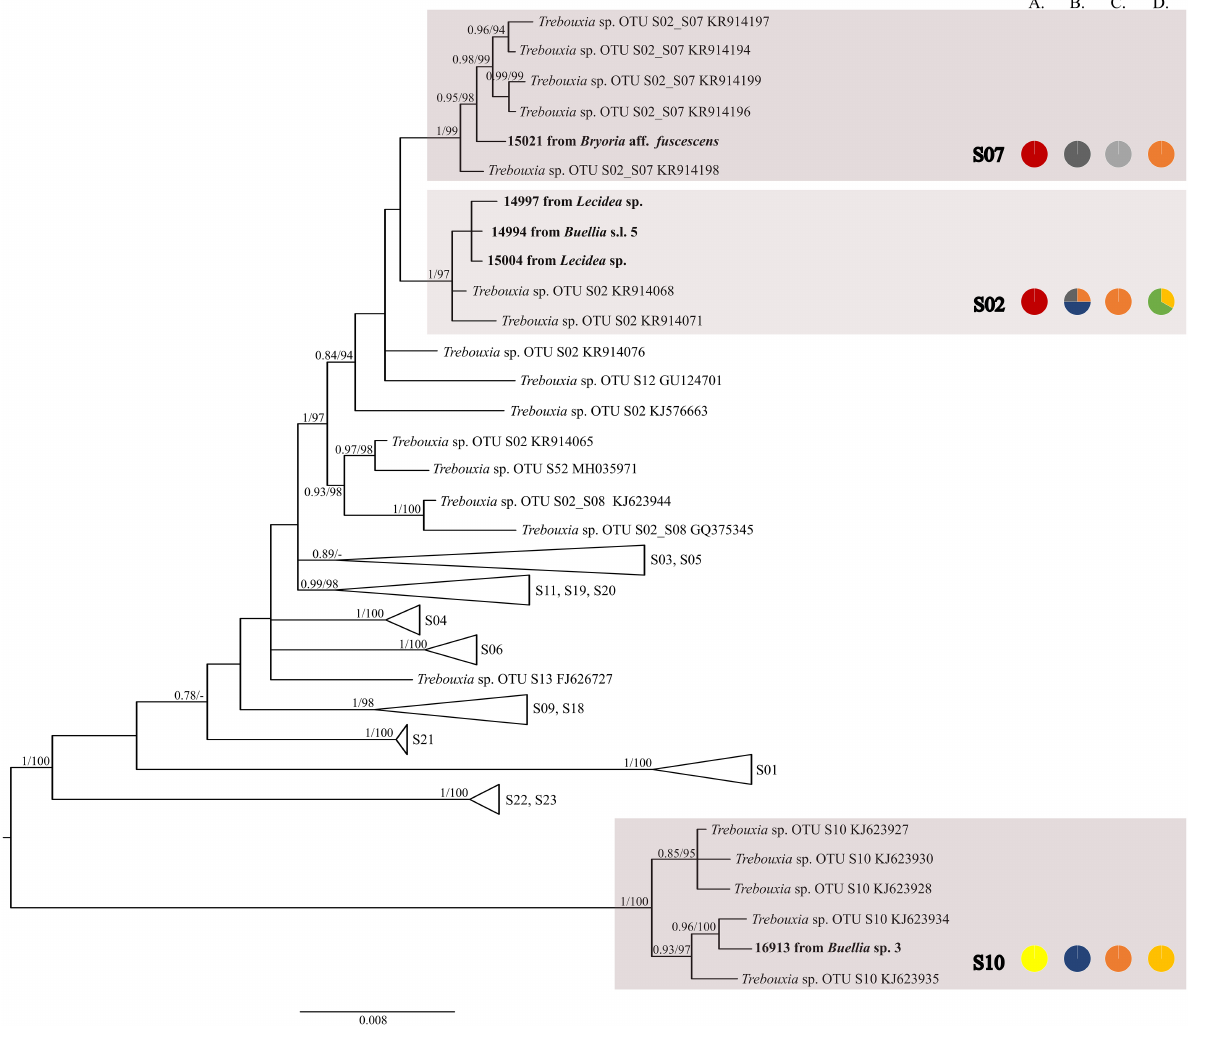
FIGURE 4 | Collapsed majority-rule consensus tree from Bayesian analysis of Trebouxia clade S based on ITS rDNA, rbc L, and cox2 locus dataset with posterior probabilities and bootstrap support values from IQ-TREE analysis presented near the branches. For each record from GenBank, accession no. with photobiont name is given (following Molins et al., 2018; Muggia et al., 2020). For newly sequenced samples voucher no. and their mycobiont host names are given. Newly sequenced photobionts from Bolivia are marked in bold. Species or phylogenetic lineages are marked in boxes with appropriate names. The first column of pie charts shows the percentage of specimens originating from open high Andean vegetation, upper montane cloud forest 2, upper montane cloud forest 1 and lower montane cloud forest in each Trebouxia lineage. The second column of pie charts shows the percentage of specimens in which defined groups of secondary metabolites were found in each Trebouxia lineage, absence of substances (A), presence of aliphatic (fatty) acids (B), anthraquinones (C), ergochromes (D), depsones (E), orcinol depsides (F), β -orcinol depsides (G), orcinol depsidones (H), β -orcinol depsidones (I), orcinol tridepsides (J), pulvinic acid derivatives (K), terpenoids (L), usnic acid derivatives (M), xanthones (N), and pigments (O). The next column of pie charts shows the percentage of specimens in each Trebouxia lineage with a given lichen growth form. In the last column of pie charts, the percentage of given lichen family is shown. The color scheme is explained in the legend on Figure 1